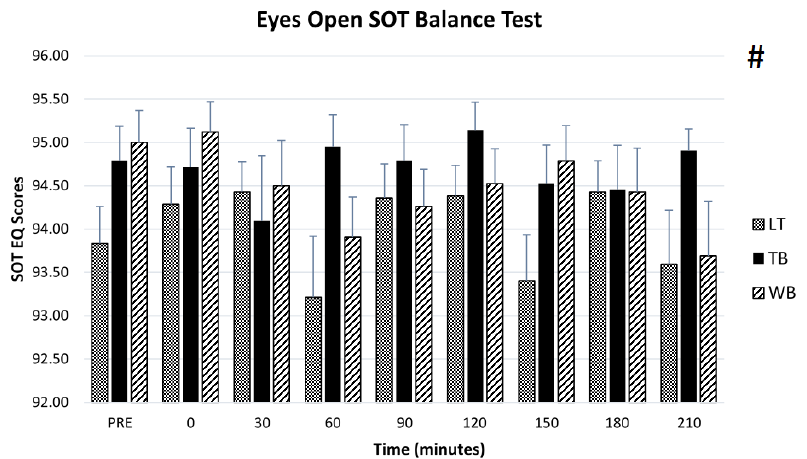
Figure 2. Mean Sensory Organization Test (SOT) Equilibrium (EQ) scores from the Eyes Open (EO) condition for all three footwear (LT, TB and WB) at nine time points. # represents a significant main effect for footwear. Bars represent standard errors.